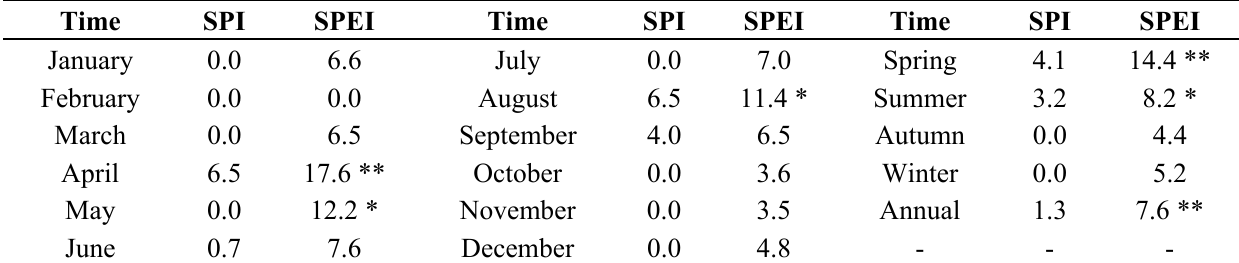
Table 3. M–K trends in drought station proportion series calculated from the SPI/SPEI values at the 3-month time scale during years 1972–2011 in